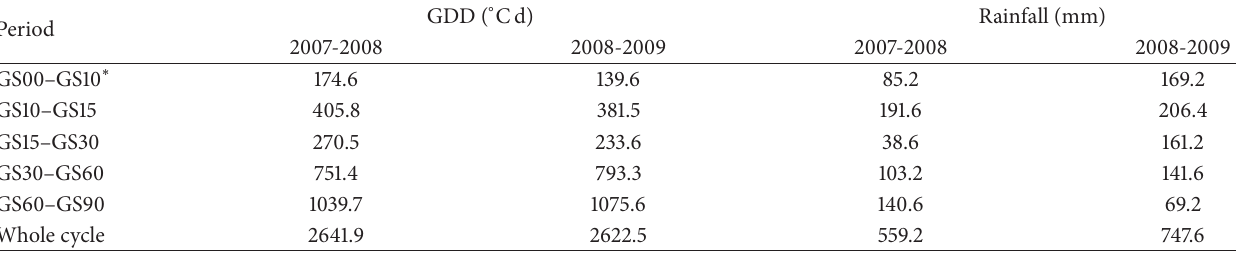
Table 1: Accumulated growing degree days (GDD) and rainfall during the whole wheat cycle and main growth periods. Growth stages are defined following Zadok’s scale [13].